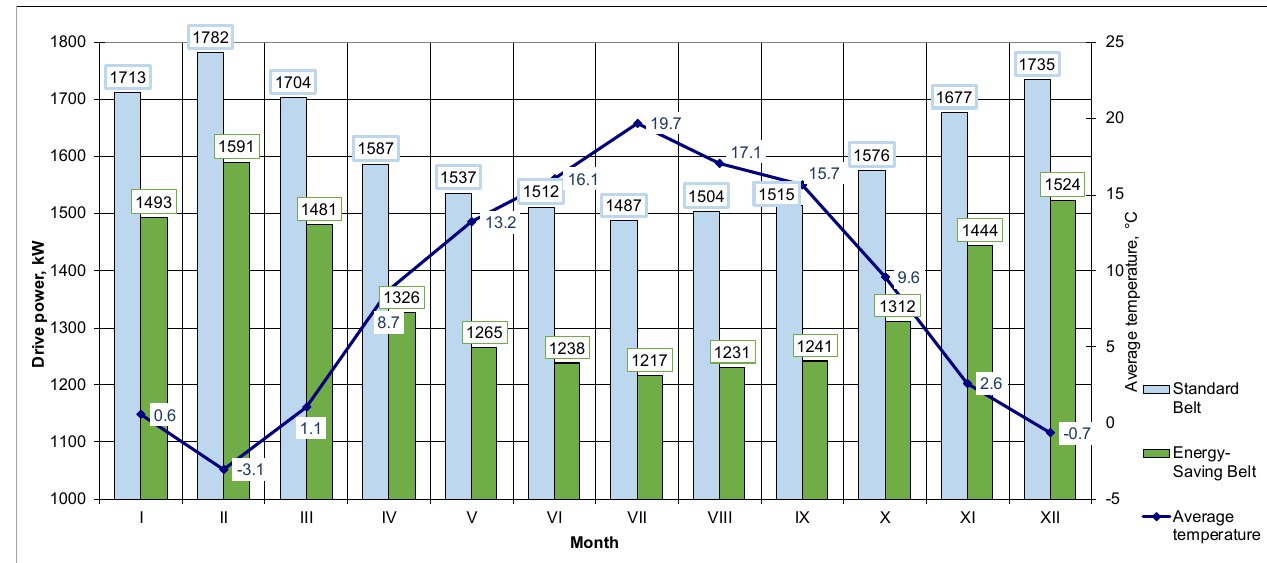
Figure 5. Relationship between power consumption and mean monthly temperatures for the 1-ST standard belt and for the 4-EO energy-saving belt.